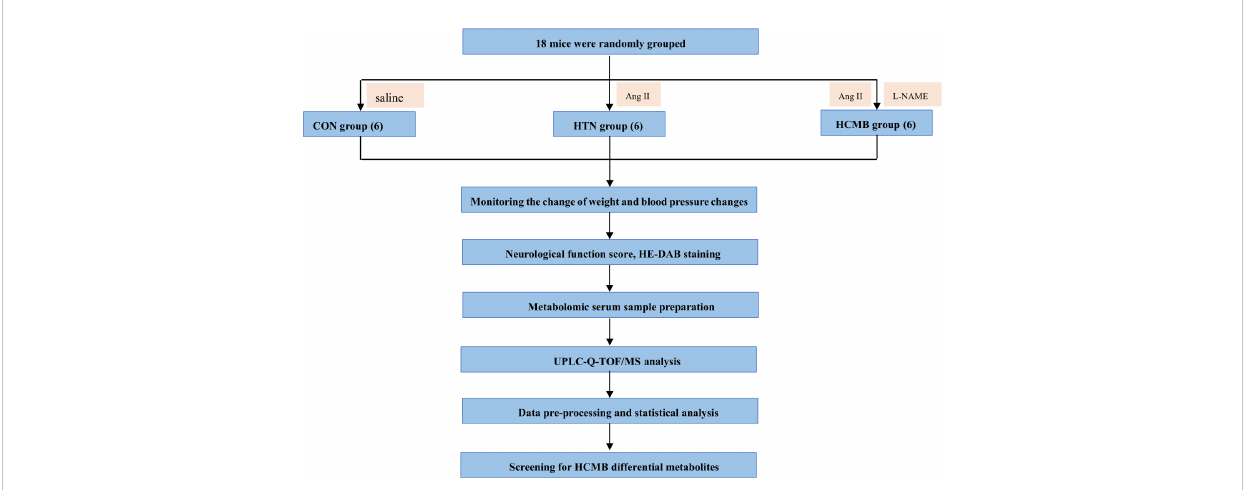
FIGURE 1 Flowchart of the study design. CON, control group; HTN, hypertension; HCMB, hypertensive cerebral microbleeds; Ang II, angiotensin II; L-NAME, levonitroarginine methyl ester; HE-DAB, Hematoxylin eosin staining and diaminobenzidine staining; UPLC-Q-TOF-MS, ultraperformance liquid chromatography coupled with quadrupole time-of- fl ight mass spectrometry